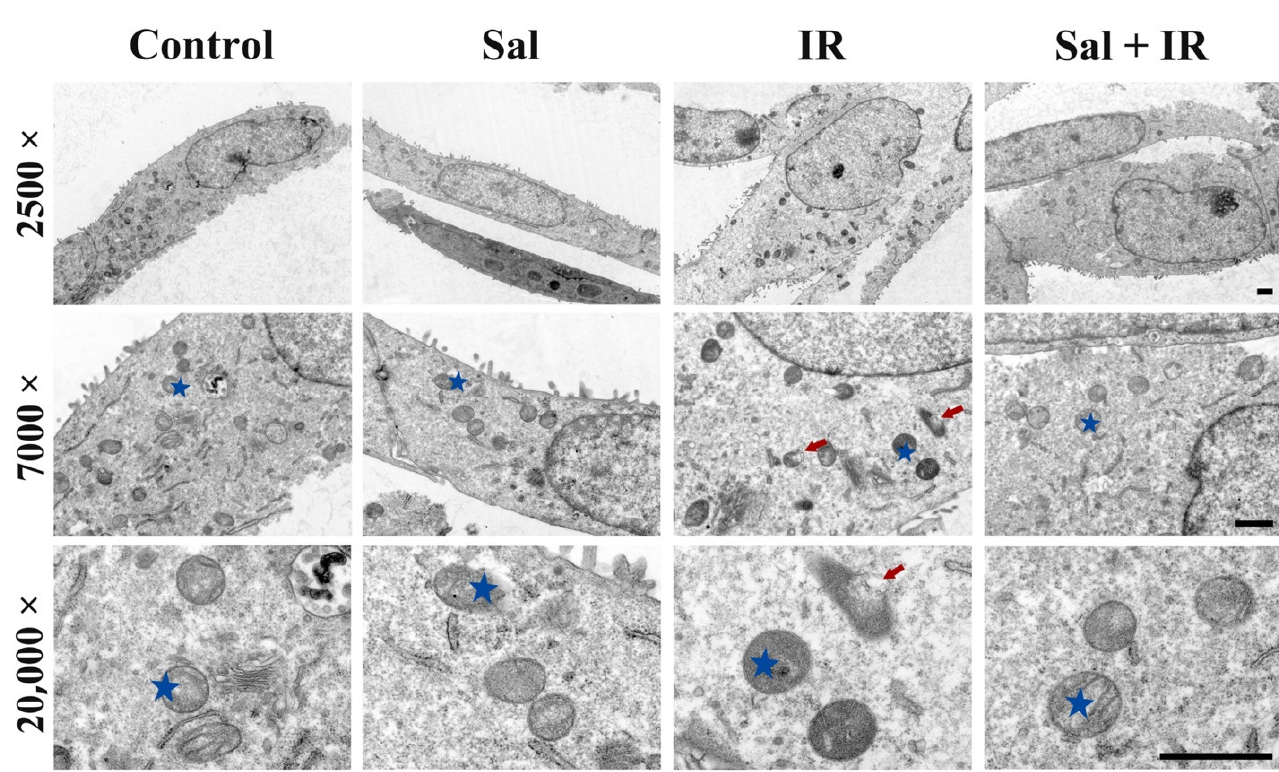
Figure 3. Salidroside rescued mitochondrial damage in irradiated SMG cells. SMG-C6 cells were pretreated with 10 µ M salidroside for 24 h before irradiation and then evaluated with TEM 48 h post-irradiation. Representative images of SMG-C6 cells are shown ( n = 3, for each group; bar = 1 µ m). The asterisk indicates a healthy mitochondrion, and the arrow indicates a damaged mitochondrion.